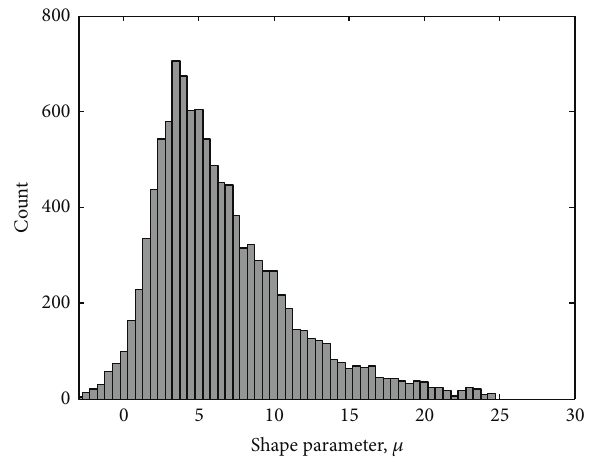
Figure 6: Histogram of estimated shape parameter 𝜇 for Gamma model.